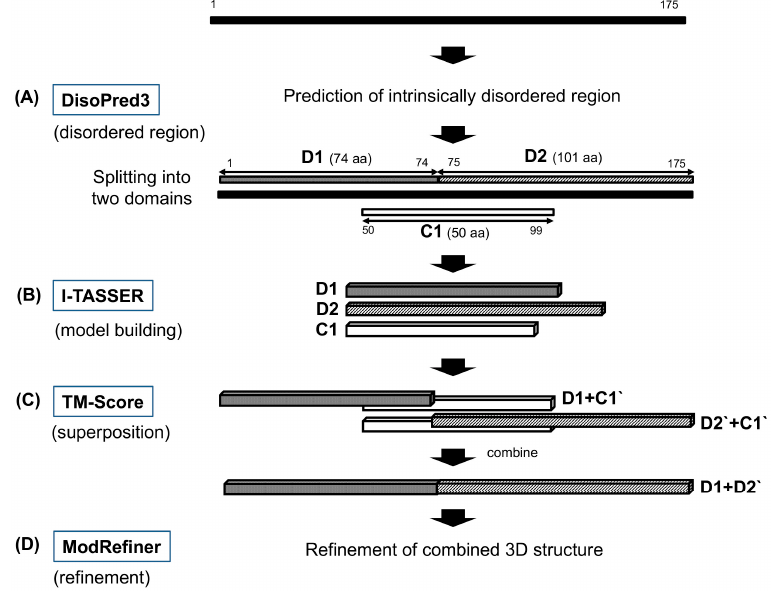
Figure 2. Workflow for the full-length and refined structure of CsTegu20.6.